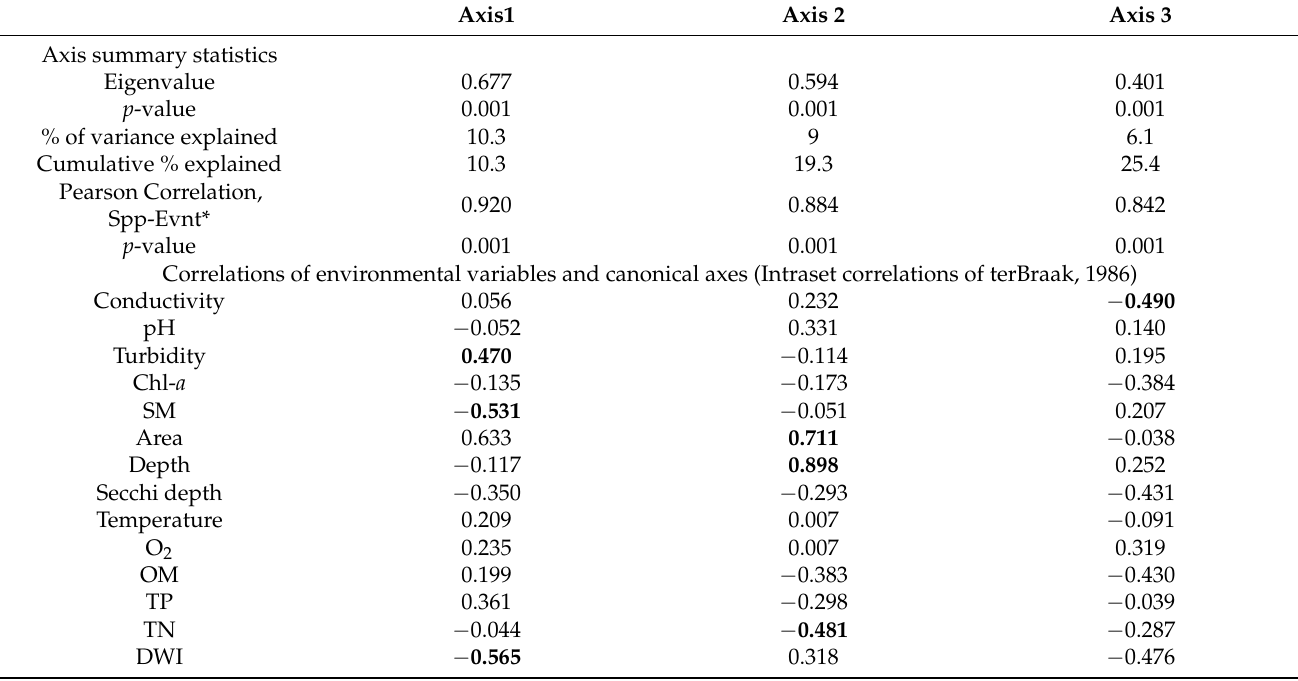
Table 5. Summary of CCA analysis among zooplankton assemblages and environmental variables. Bold letters reflect the significant related variables for each axis. Axis1 Axis 2 Axis